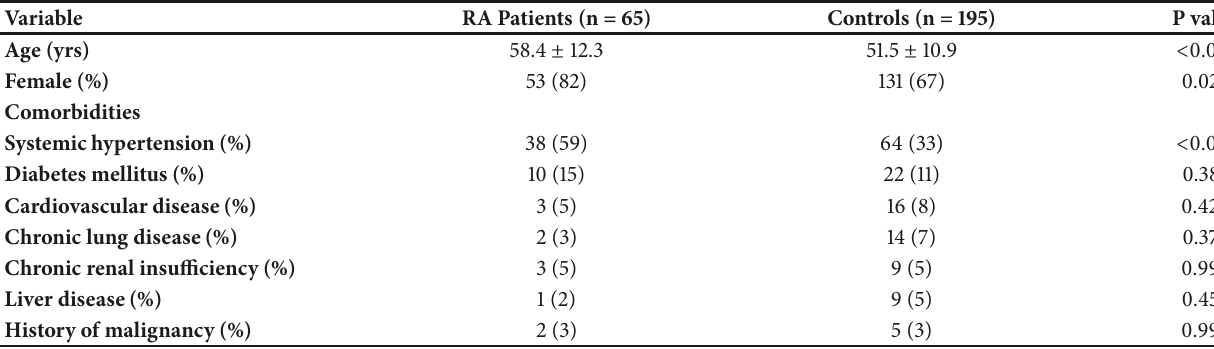
Table 1: Baseline characteristics of study participants.